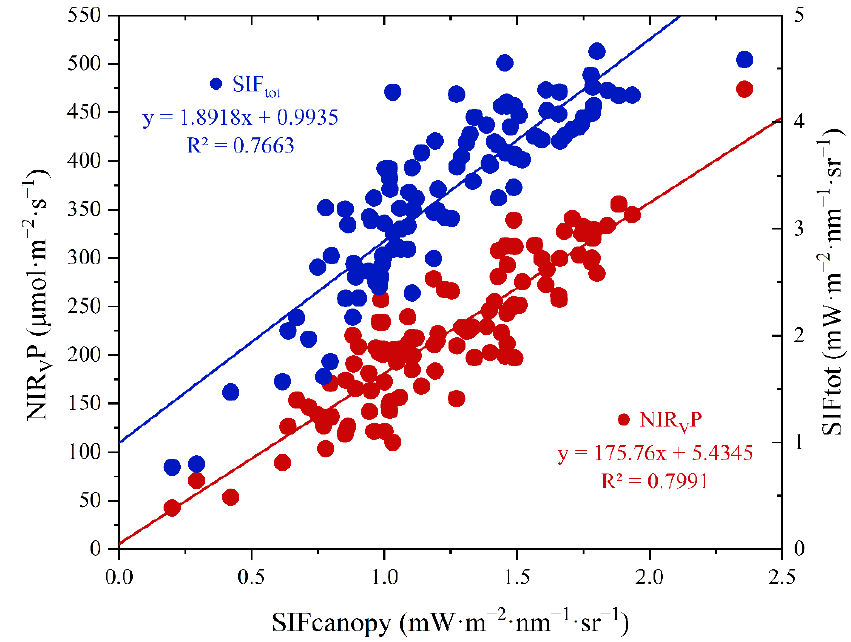
Figure 2. Overview of the relationships between SIF canopy and SIF canopy -related variables in the mild stage of disease onset ( n = 104).